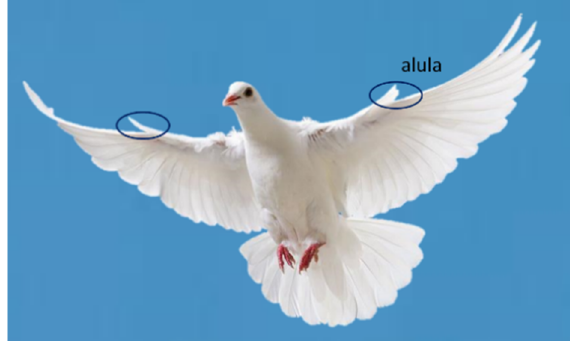
Figure 1. The deflection of the alula in a pigeon’s flight.